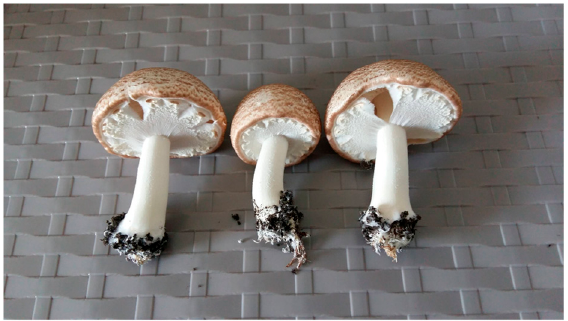
Figure B5. Formation of fructification primes: ( left ) V6 experimental variant; ( right ) V9 experimental variant. Source: Photo original—SC CIUPERC Ă RIA SRL, Aghiresu-Fabrici, Cluj County.